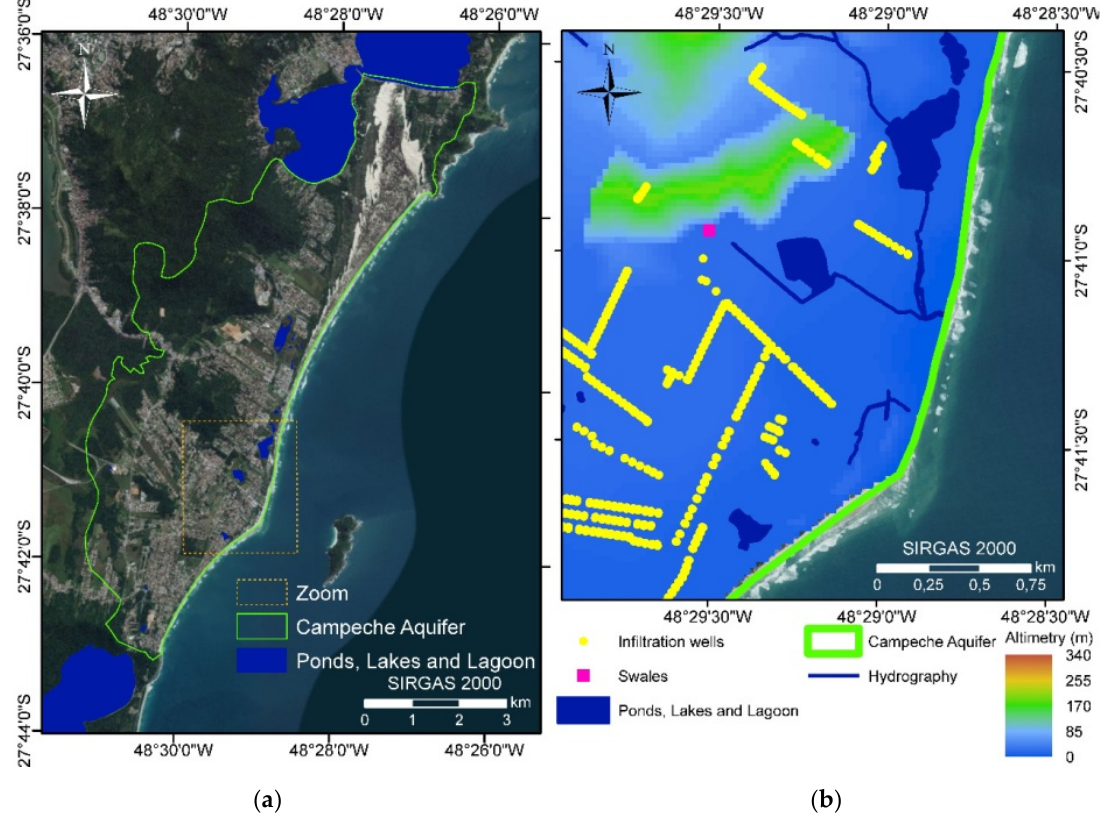
Figure 2. ( a ) Hydrography details in the vicinity of the infiltration swale; ( b ) presence of infiltration structures near the